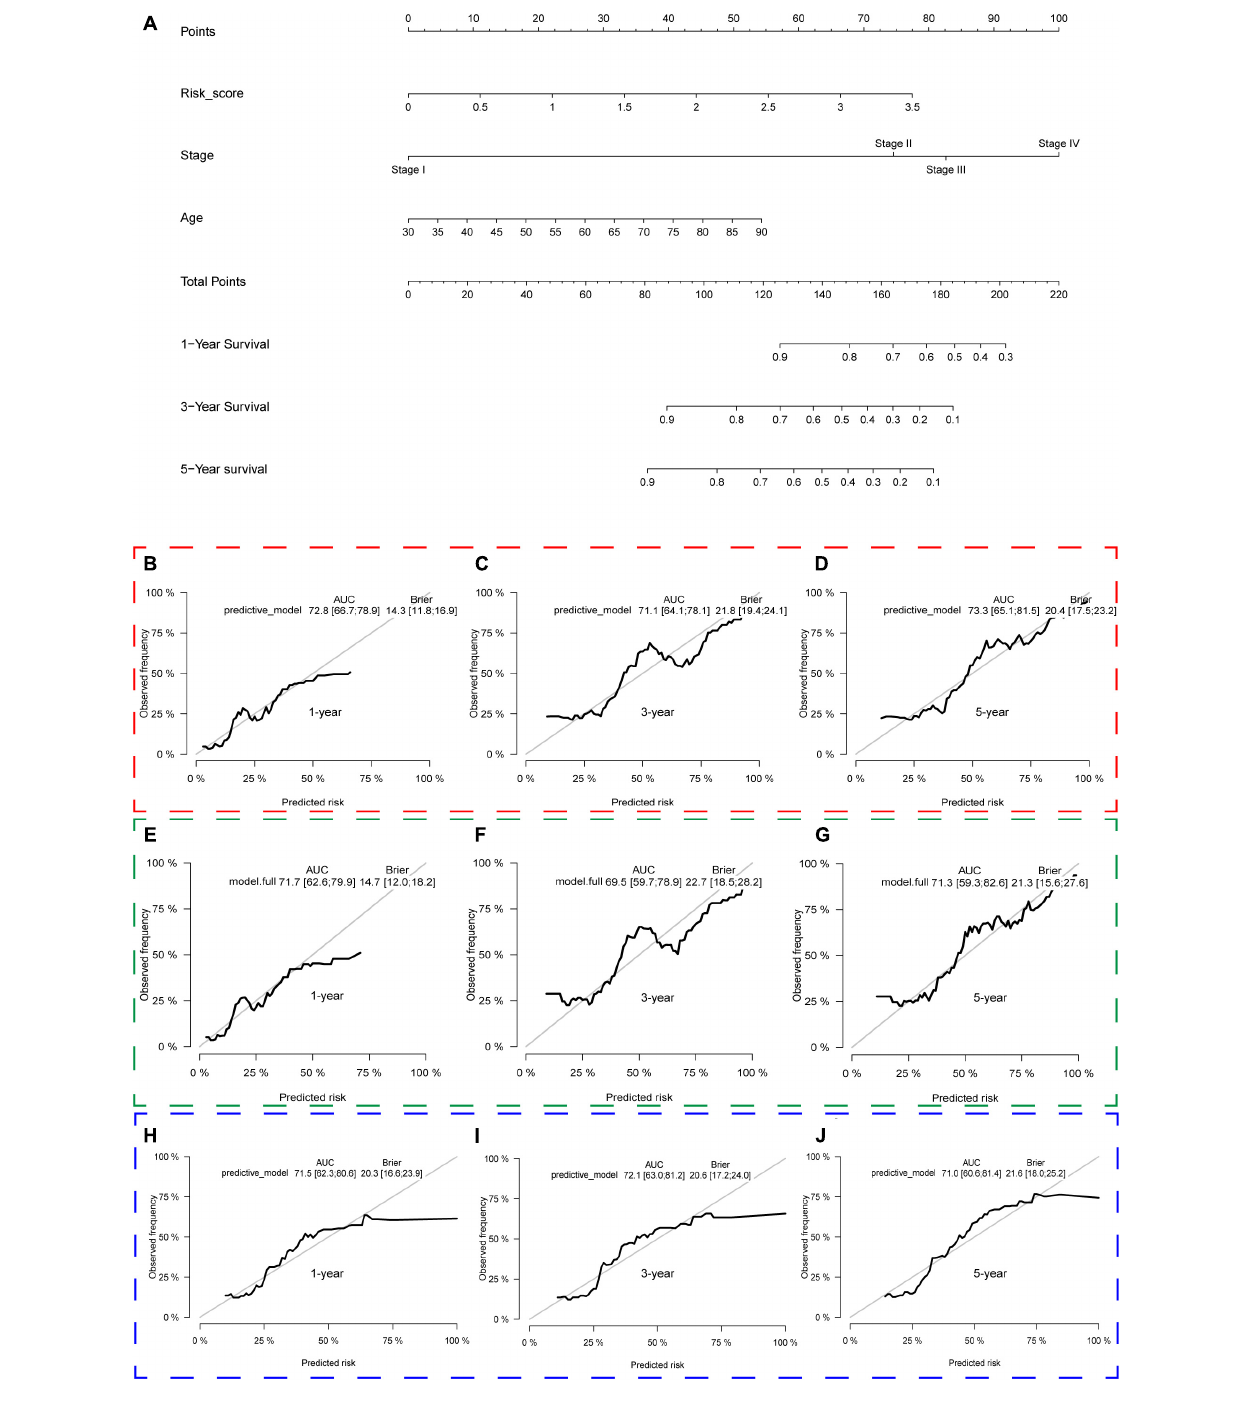
Liu et al., 2020). To explore the relationships between the hypoxia signature and immune cell infiltration, we compared the immune cell content of different risk score groups and found that